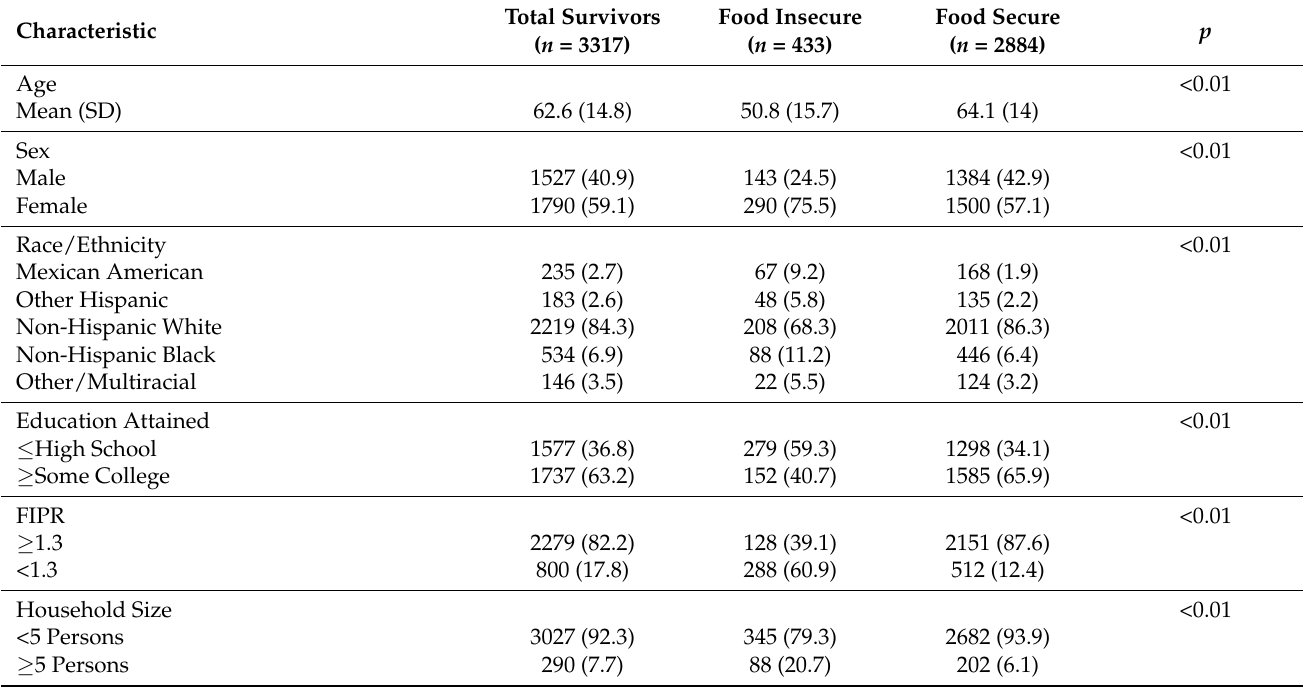
Table 1. Sociodemographic and behavioral characteristics of the cancer survivor study sample (subsample A in Figure 1) and stratified by food security status. Frequencies and means are presented with percentages and standard deviations, respectively, in